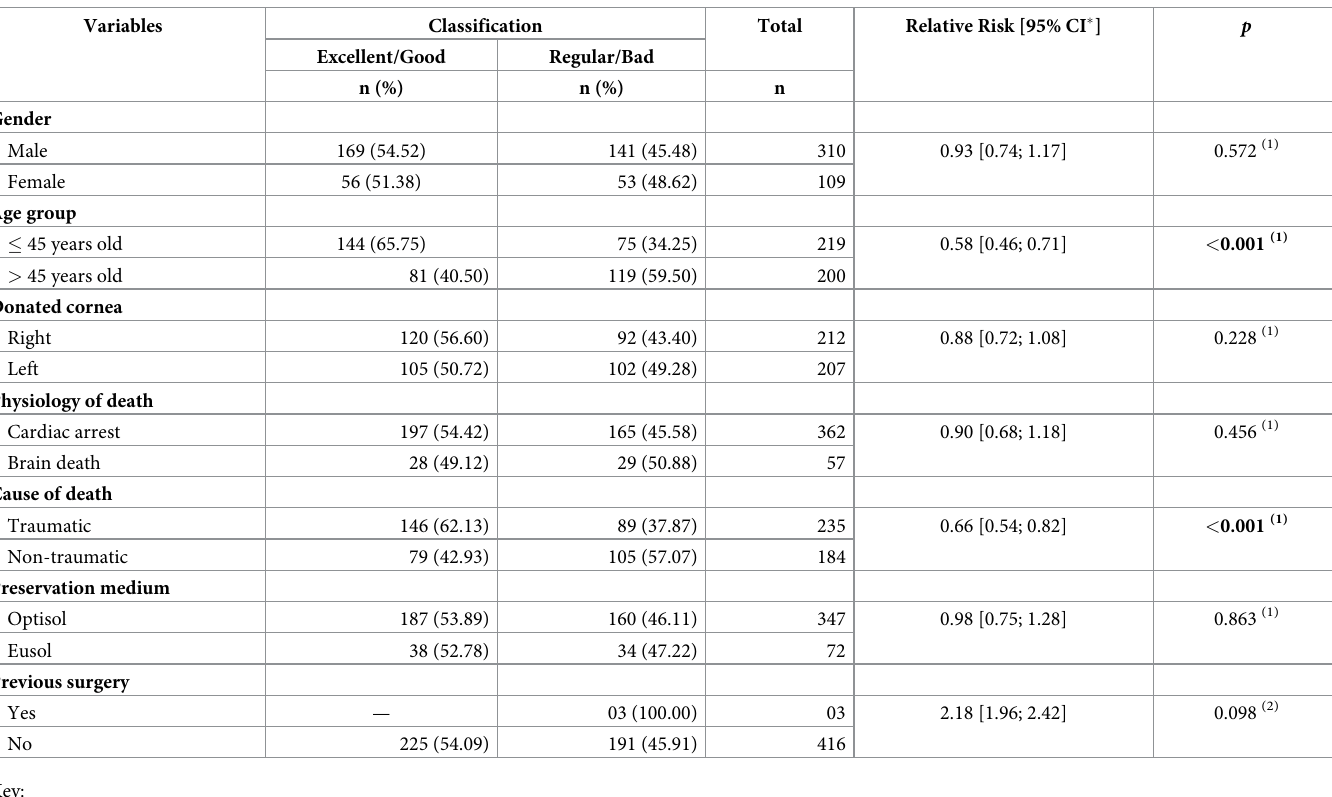
Table 3. Corneal quality versus demographic and clinical data, Brazil, 2020 (n = 419). Variables